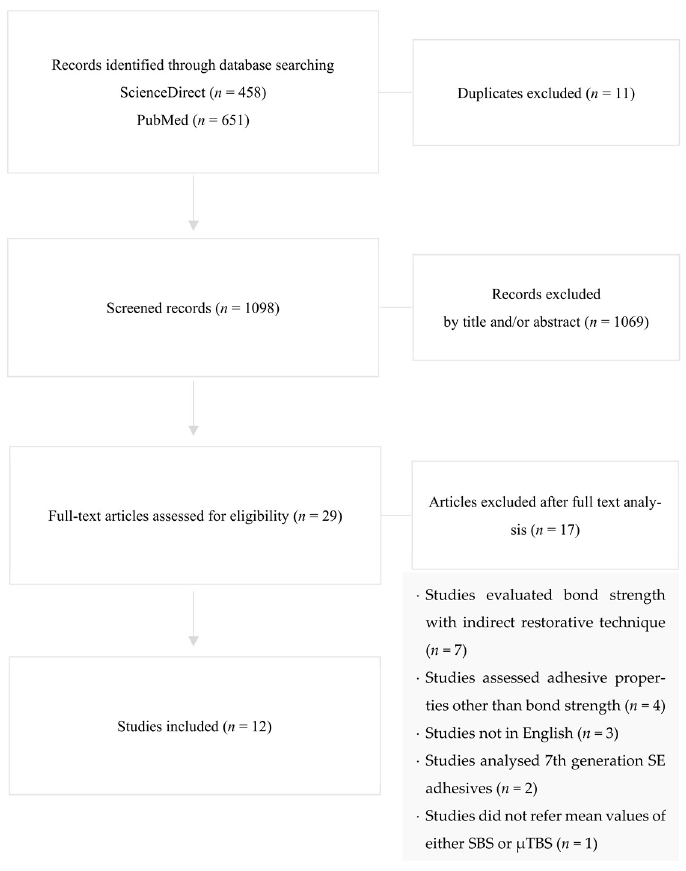
Figure 1. Systematic review search flowchart, according to PRISMA, illustrating the study inclusion.